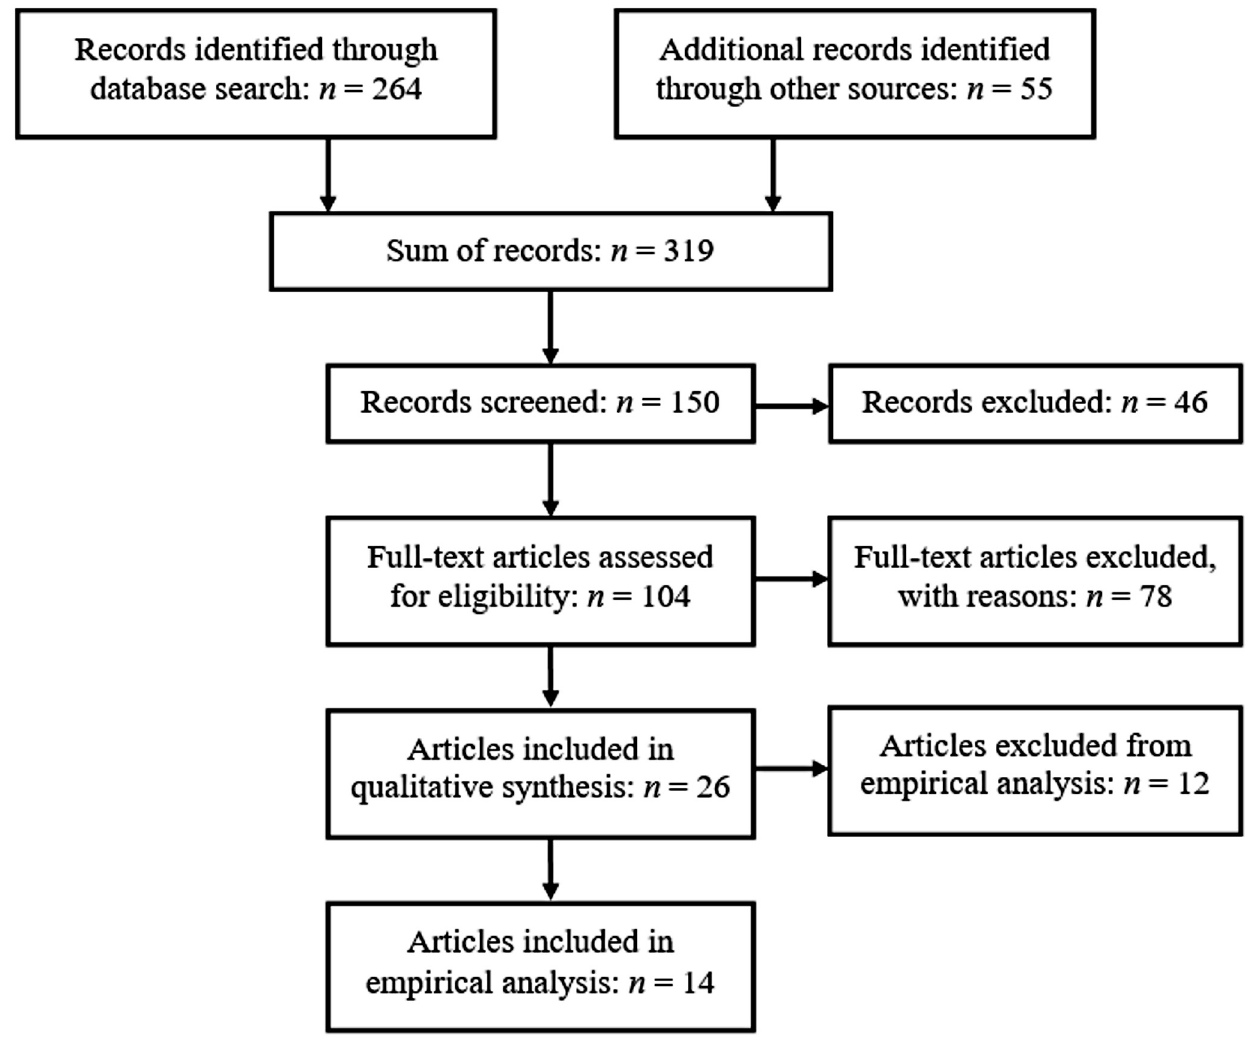
Fig 1. Flow chart of reviewed studies. Duplicates were removed automatically by the provider of the databases during database search; during additional manual record search (other sources), duplicates were excluded from the